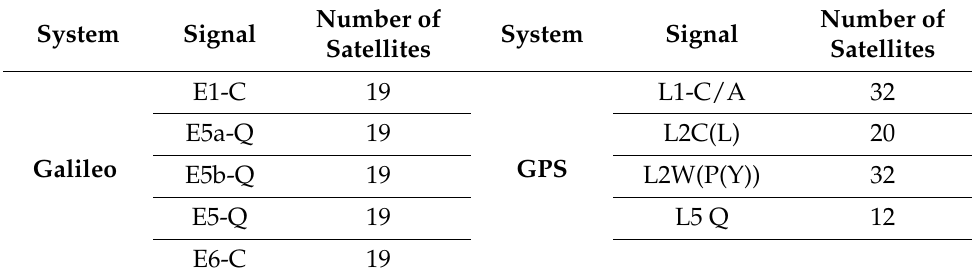
Table 1. Type of observations used in the